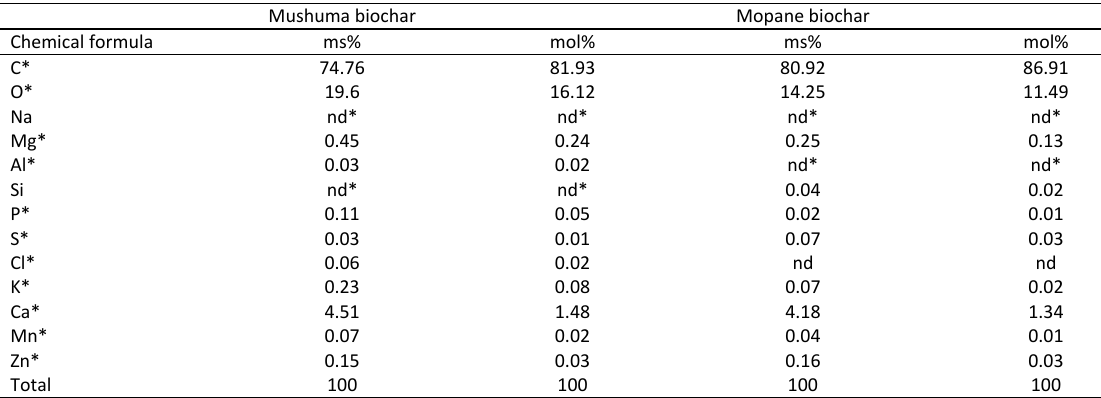
nd*-not detected